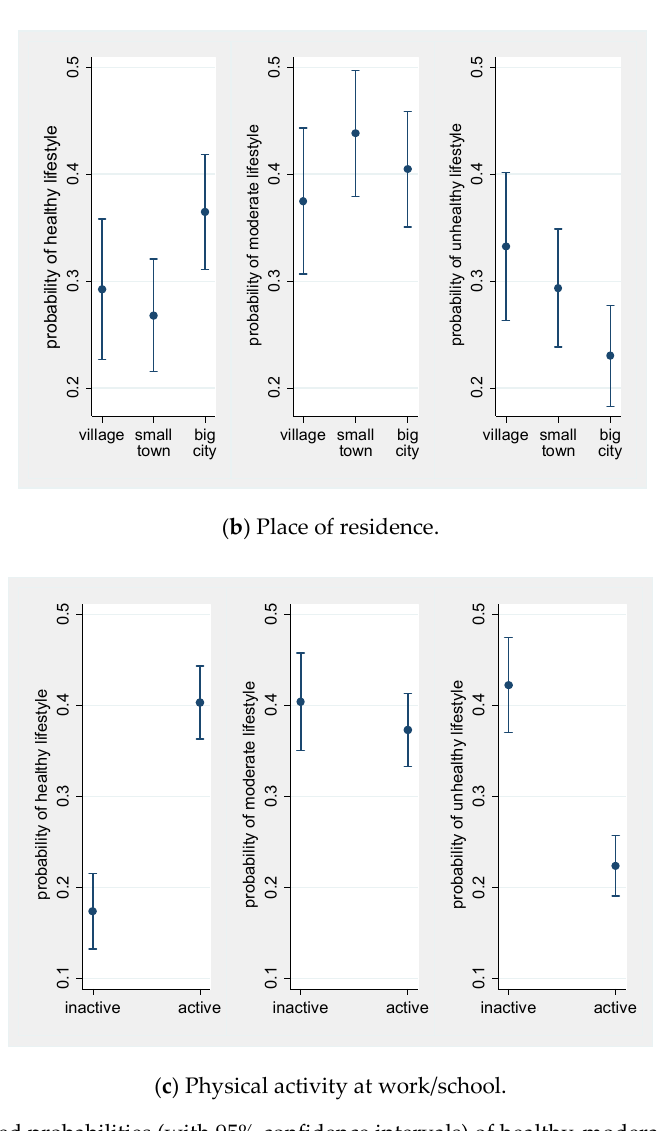
Figure 1. Predicted probabilities (with 95% confidence intervals) of healthy, moderate, and unhealthy lifestyle at each category of ( a ) health status, ( b ) place of residence, and ( c ) activity at work/school.